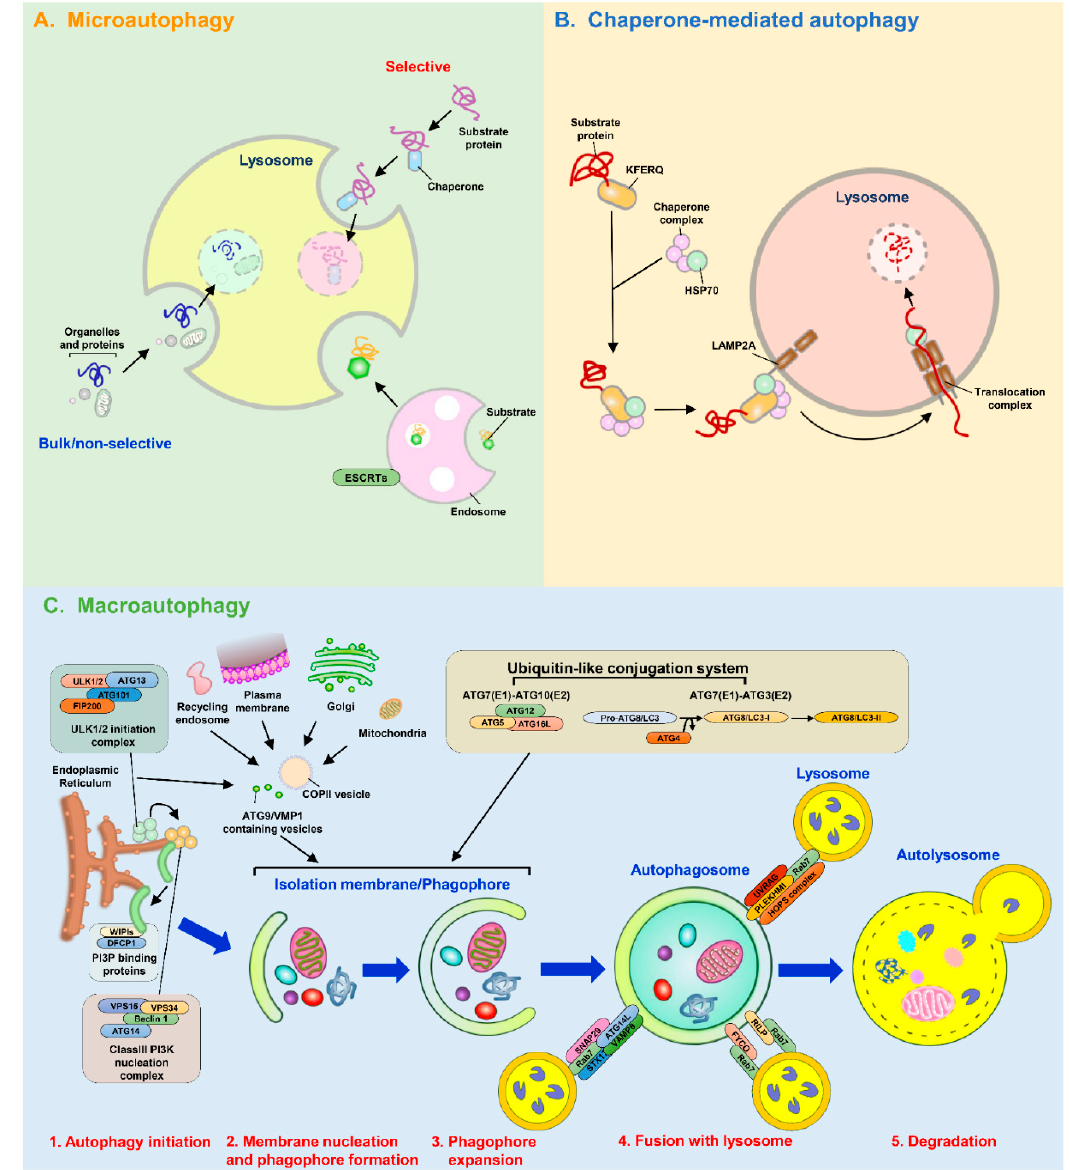
Figure 1. Overview of the molecular mechanisms regulating autophagy. Autophagy is classified into three major types: microautophagy, chaperone-mediated autophagy (CMA), and macroautophagy. ( A ) Microautophagy is a dynamic lysosomal membrane process that directly enwraps and deliver the intracellular portions to the lumen of lysosomes for degradation. ( B ) CMA is a lysosomal degradation process that involves the recognition of proteins containing the KFERQ-like motif by HSC70 and transport into the lysosomal lumen via the interaction with LAMP2A. ( C ) Macroautophagy (referred to here as autophagy) is a degradation pathway that promotes membrane rearrangement to generate vacuoles to engulf the cytosolic components targeted for degradation within lysosome. Two distinct metabolic sensors, AMPK and the mTOR complex, control the initiation of autophagy. Nutrient starvation in cells triggers the suppression of mTOR by AMPK1and the translocation of the ULK1/2 complex (ULK1/2, ATG13, RB1-inducible coiled-coil 1 (RB1CC1, also known as FIP200) and ATG101) to the autophagy initiation site. Subsequently, the ULK1/2 complex leads to the recruitment and activation of the class III phosphatidylinositol-3-OH kinase (class III-PI3K complex, including Vps34/PI3KC3, Vps15, Beclin 1, and ATG14) to synthesize PtdIn(3)P. The generated PtdIn(3)P then